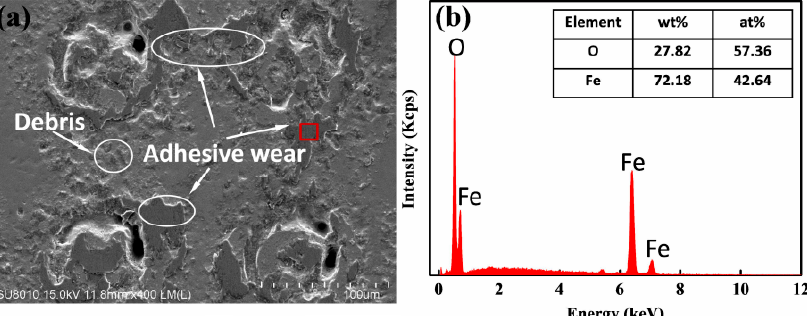
Figure 10. ( a ) SEM image of the wear scar and ( b ) EDS results of the sample. Adapted with permission from Ref. [71]. 2019, Elsevier.